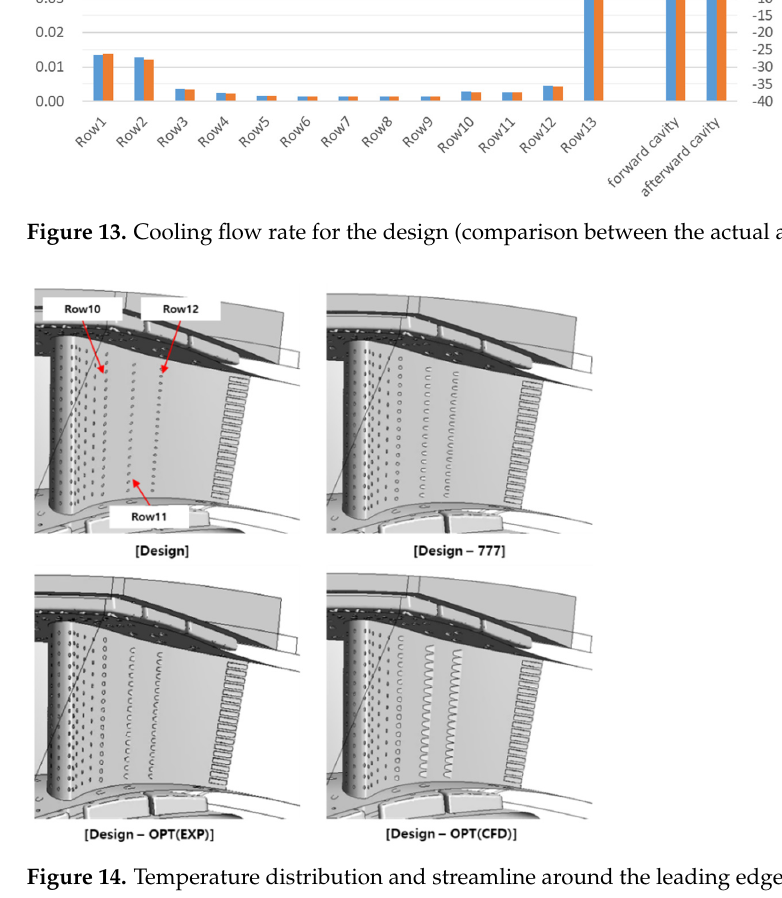
Figure 14. Temperature distribution and streamline around the leading edge.